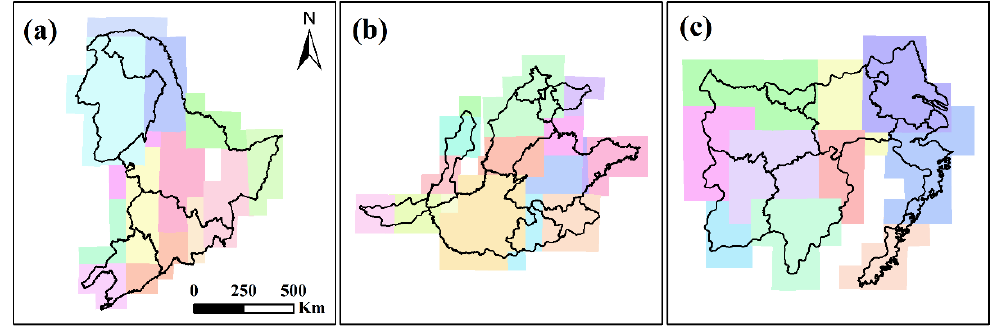
Figure 3. Distribution of the subregions on the Northeast Plain ( a ), North China Plain ( b ), and middle-lower Yangtze River plain ( c ). Different colors represent different subregions.